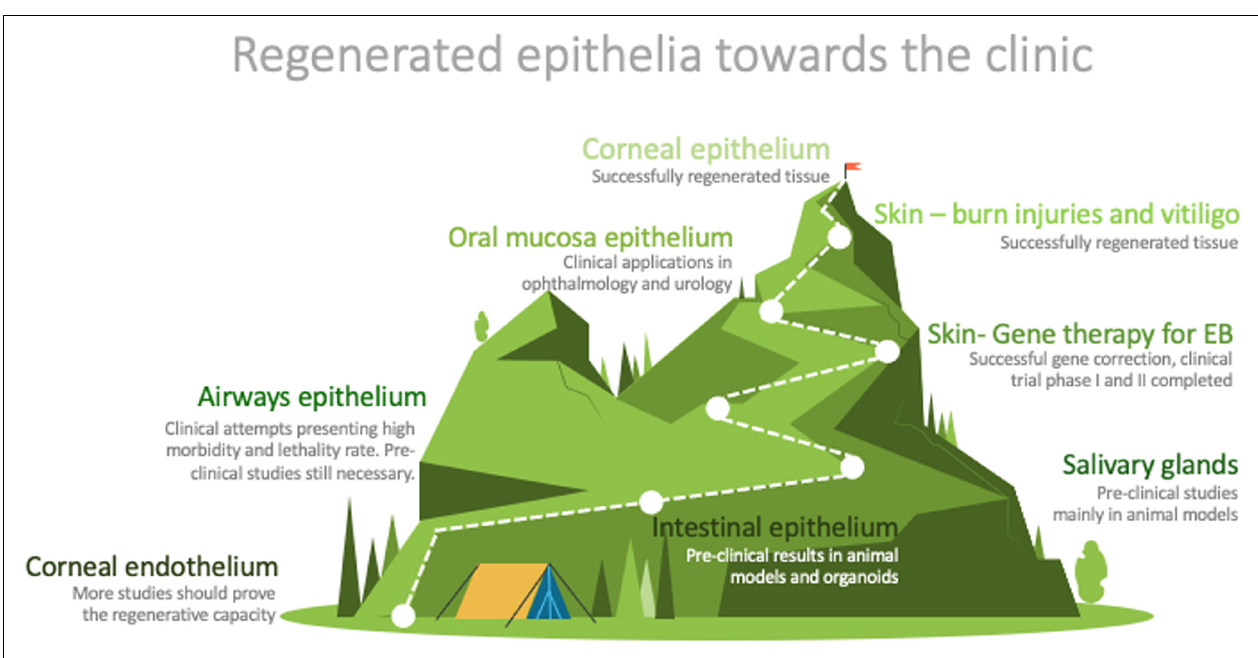
FIGURE 2 | Graphic representation of the distance between research and routine clinical application of the described epithelia. Designed by PoweredTemplate.